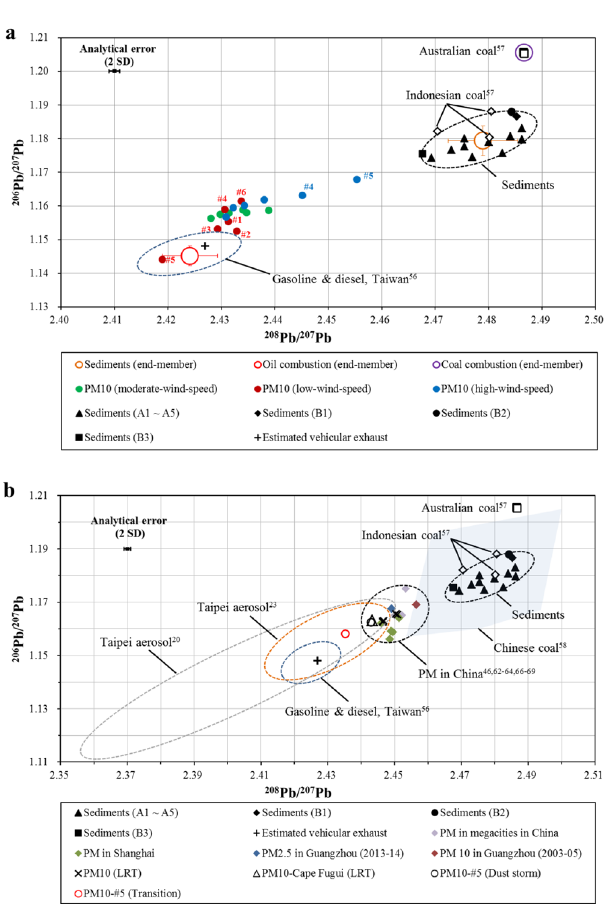
Figure 4. ( a ) Triple isotope plot of the Pb in PM 10 during the local events. Pb isotope ratios of potential end- members (e.g., Oil combustion/refineries, coal combustion, and sediments) are also shown as red, purple, and orange open circles, respectively. ( b ) Triple isotope plot of the Pb in PM 10 during the long-range transport and the dust storm events. Pb isotope ratios of PMs collected in Taipei 20,23 , China 46,62–64,66–69 , are also plotted for